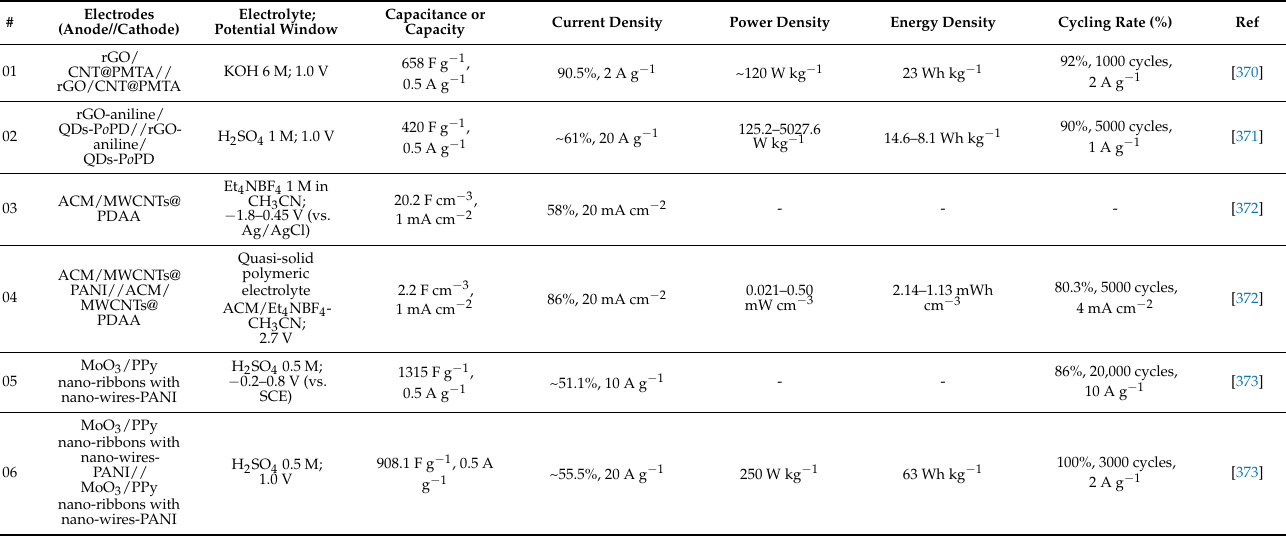
Table 5. Other polymeric nanostructures evaluated for supercapacitor electrodes, with their perfor- mance